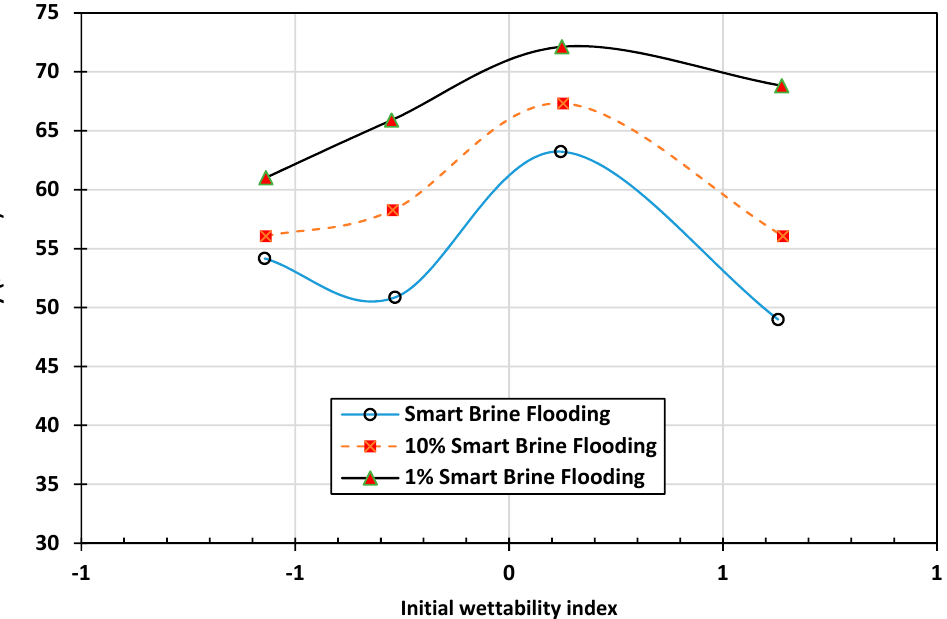
Figure 1. Relationship between initial core wettability and secondary water flood oil recovery with injection of high- and low-salinity brines (Hadia et al., 2013) [13]. SB = Smart Brine. Recovery is higher in the range of neutral wettability in all cases and smart water flood (1% SB) is superior compared with the other two water floods.